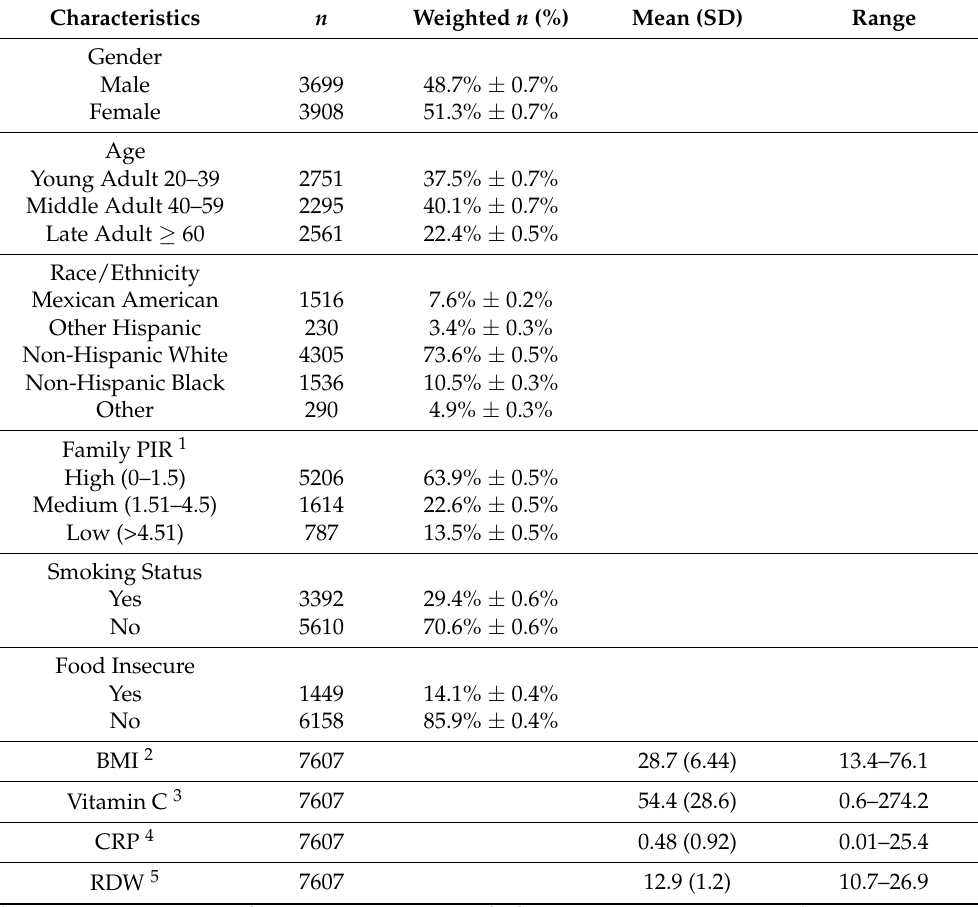
Table 1. Sample description ( n =